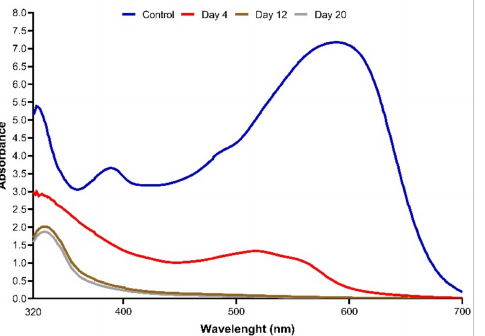
Figure 8. UV–Vis spectra of original textile dyes at day 0 and after treatment by immobilised T. hirsuta PW17-41 on days 4, 12 and 20 under optimal conditions.